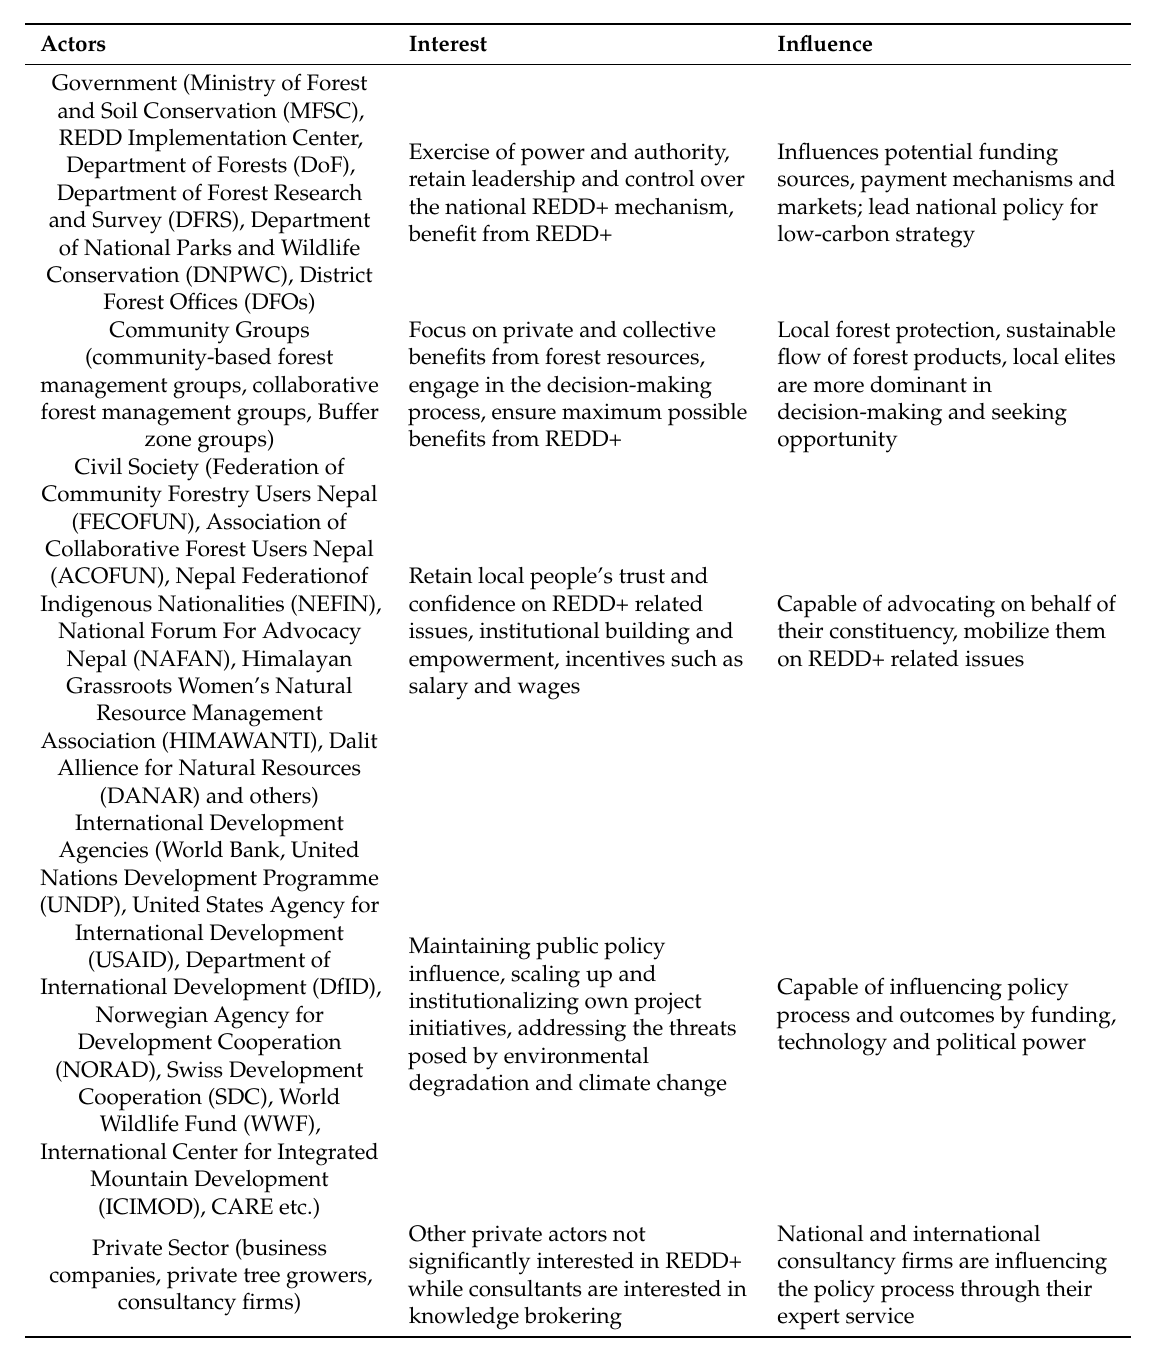
Table 1. Actors, their interest and influence in Nepal’s REDD+ policy